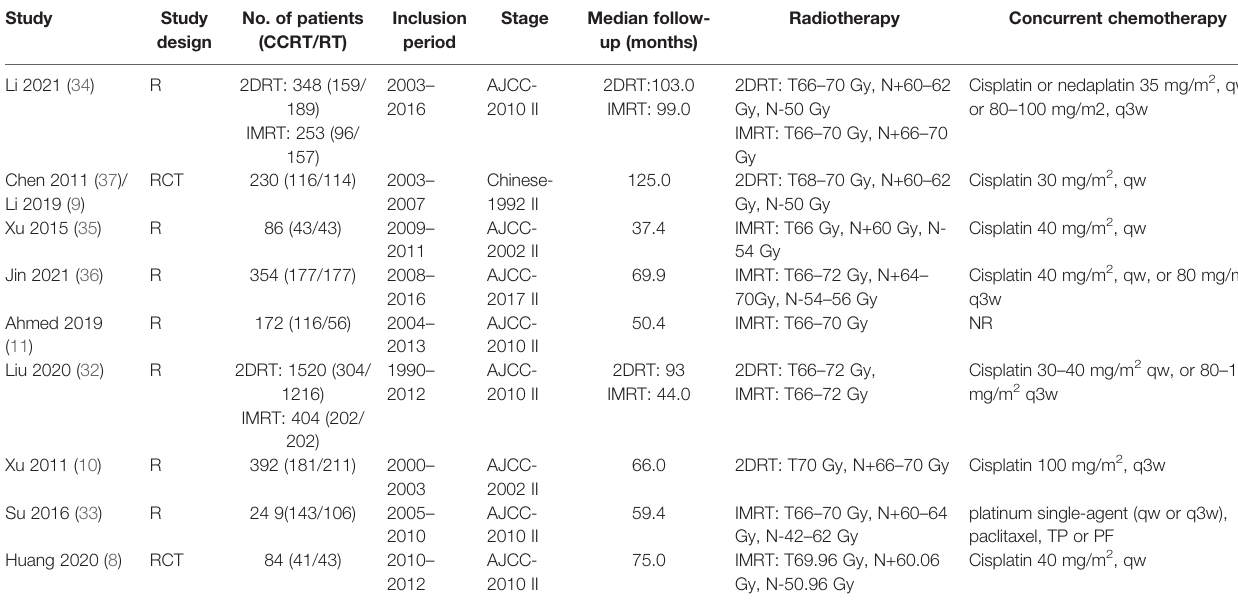
FIGURE 1 | PRISMA fl ow diagram. TABLE 1 | Eligible study